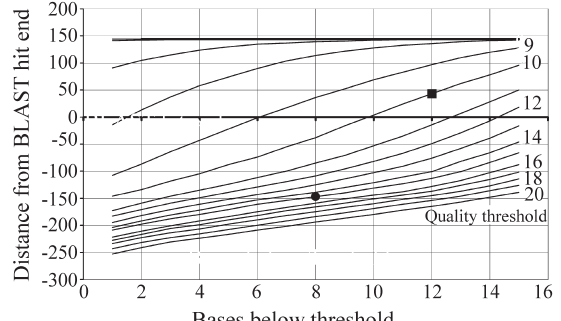
Figure 2 - Distribution of the number of bases kept at the 3’ end with a quality window size of 20, with respect to the best BLAST hits against